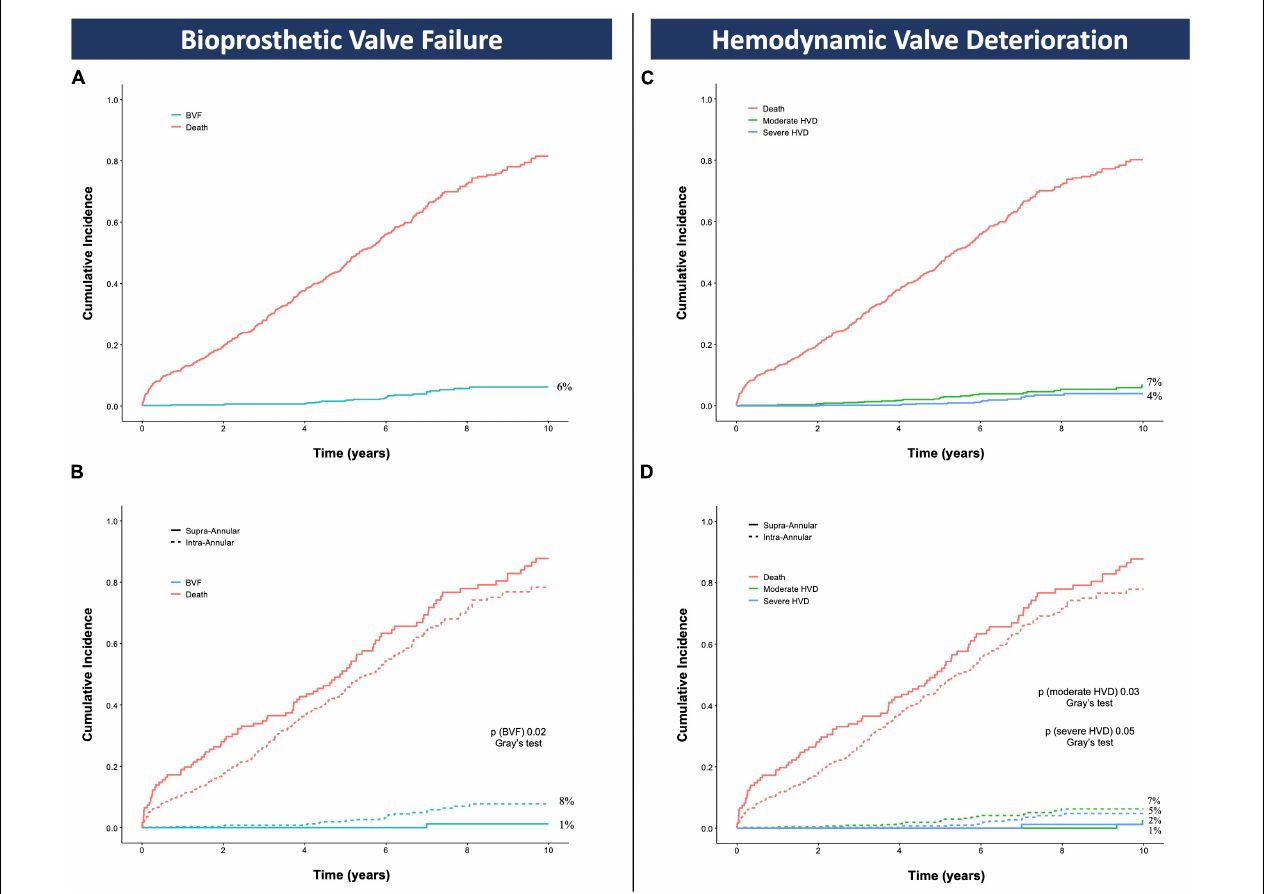
FIGURE 3 | Cumulative incidence function of bioprosthetic valve failure (A,B) and hemodynamic valve deterioration (C,D) accounting for death as competing risk; p values are obtained with the Gray’s test and refer to the comparison between the intra-annular and the supra-annular group. BVF, bioprosthetic valve failure; HVD, hemodynamic valve